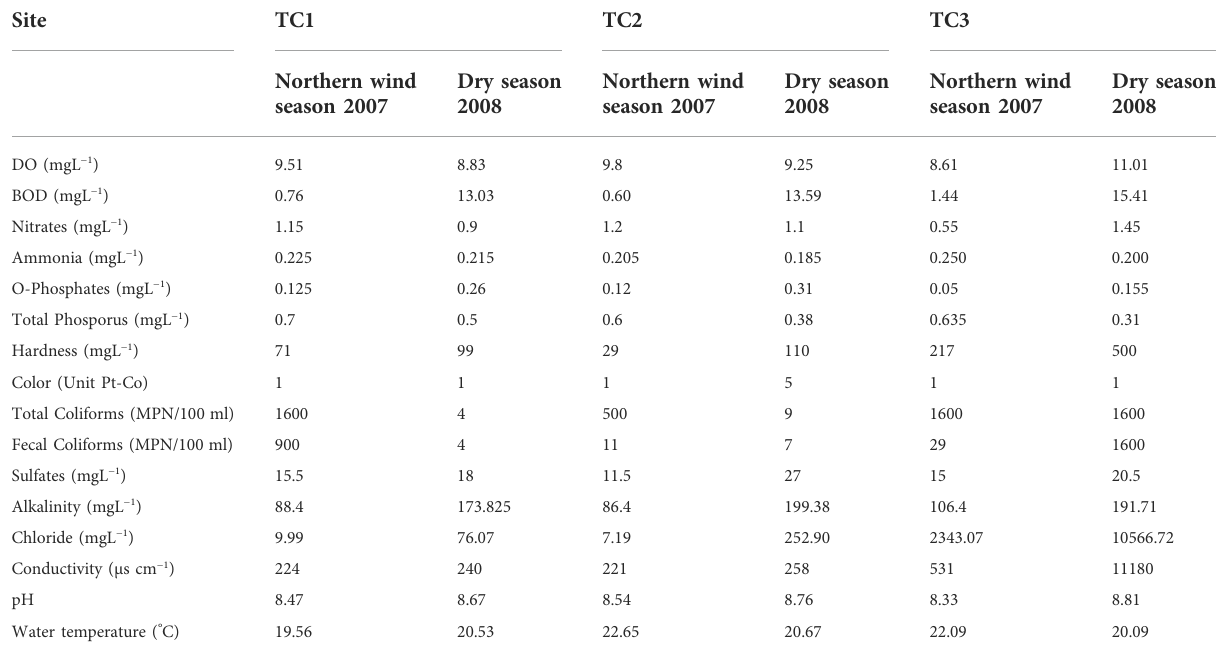
TABLE 1 Water quality features for Tecolutla river.